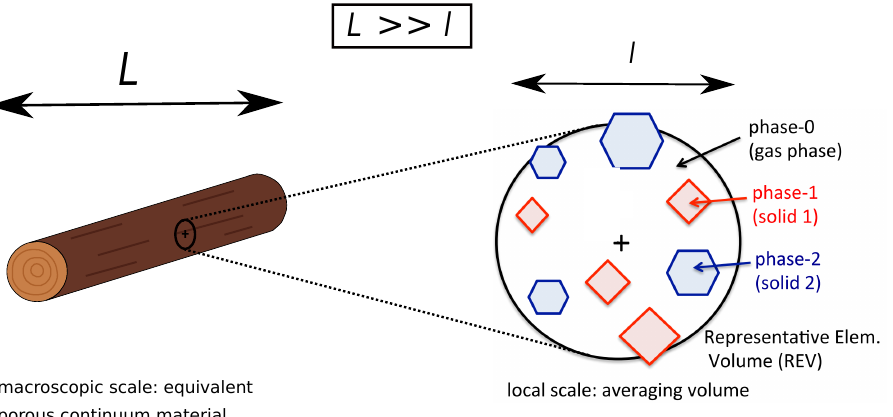
Figure 2. Illustration of the problem: interaction between a multi-phase reactive material with a multi-species reactive gas mixture. The model characterizes this problem at the macroscopic scale under the assumption of scale separation ( L >> l